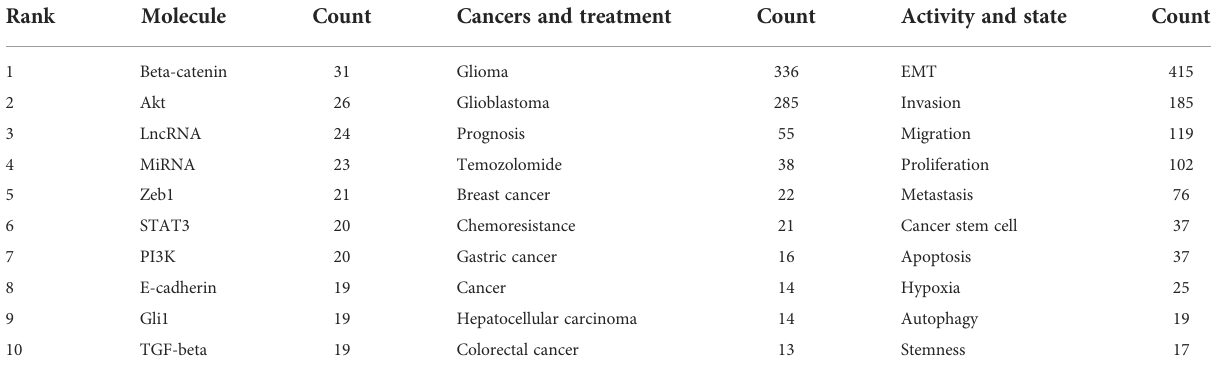
TABLE 2 The top 10 molecule, disease and treatment, and activity and state words in the author keywords. Rank